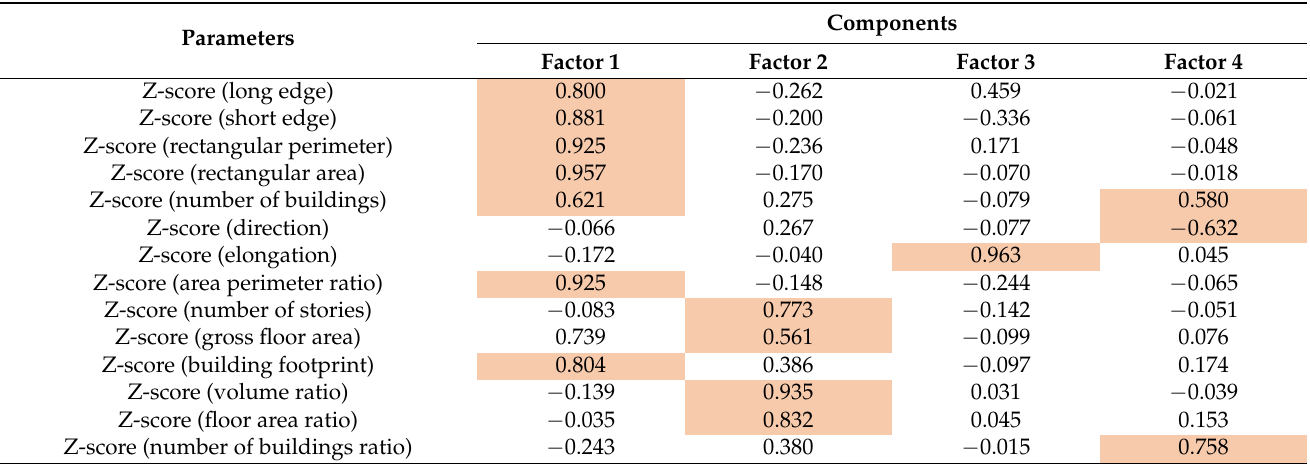
Table 3. Rotated component